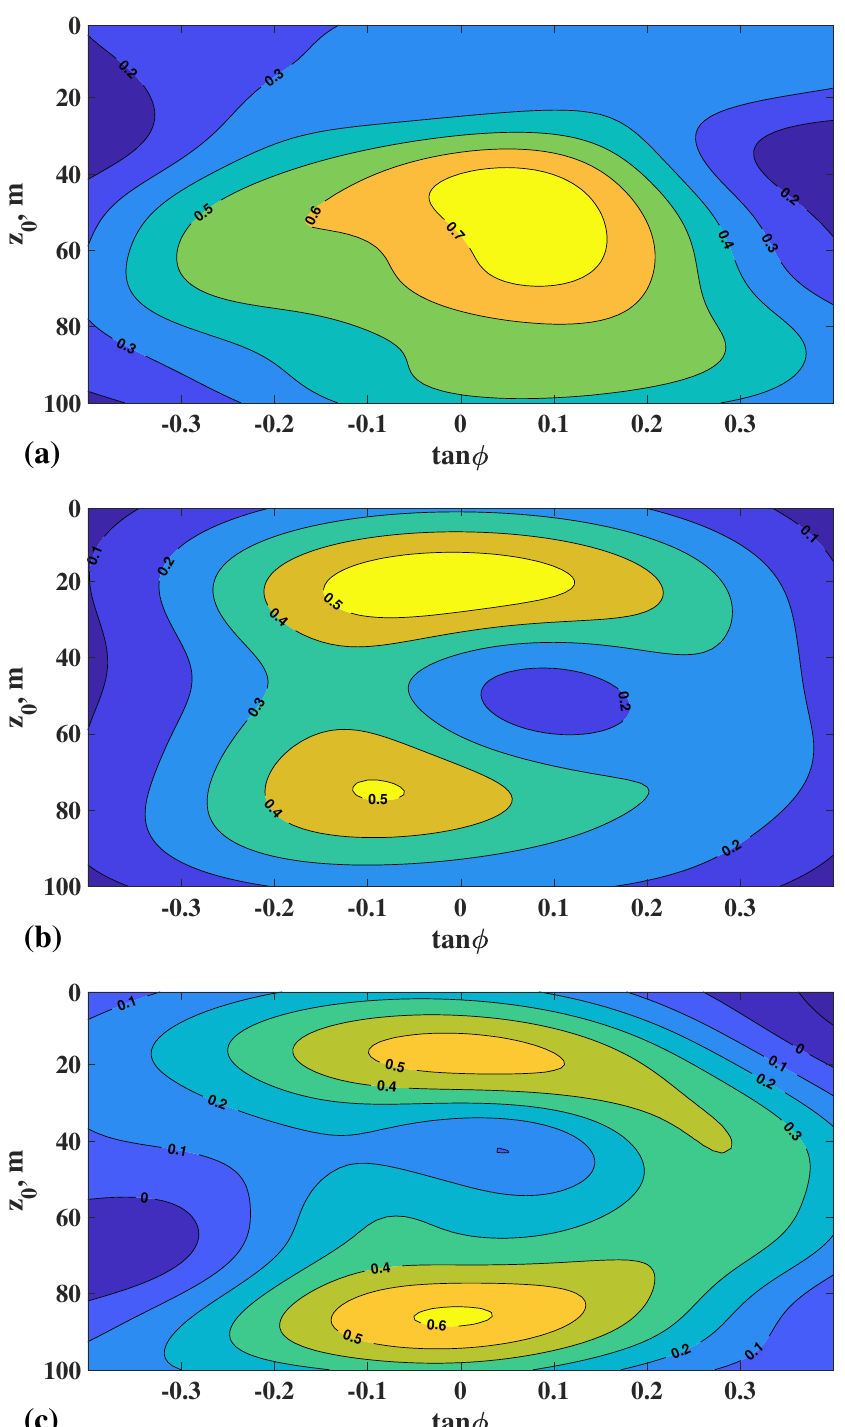
Figure 3. Scanning of the waveguide crossing the pockmark between r 1 = 2000 m and r 2 = 2300 m. Panel ( a ) shows dependence of the transmission coefficient on tangent of the launching angle and √ the initial depth z 0 of a directed Gaussian wave beam, the noise amplitude σ = 0.05. Panels ( b , c ) illustrate the difference δ T in the same coordinates as in the panel ( a ). The panel ( b ) corresponds to data obtained with the propagator without impact of noise, and the panel ( c ) shows data averaged √ over 100 realizations of ambient noise with the amplitude σ =